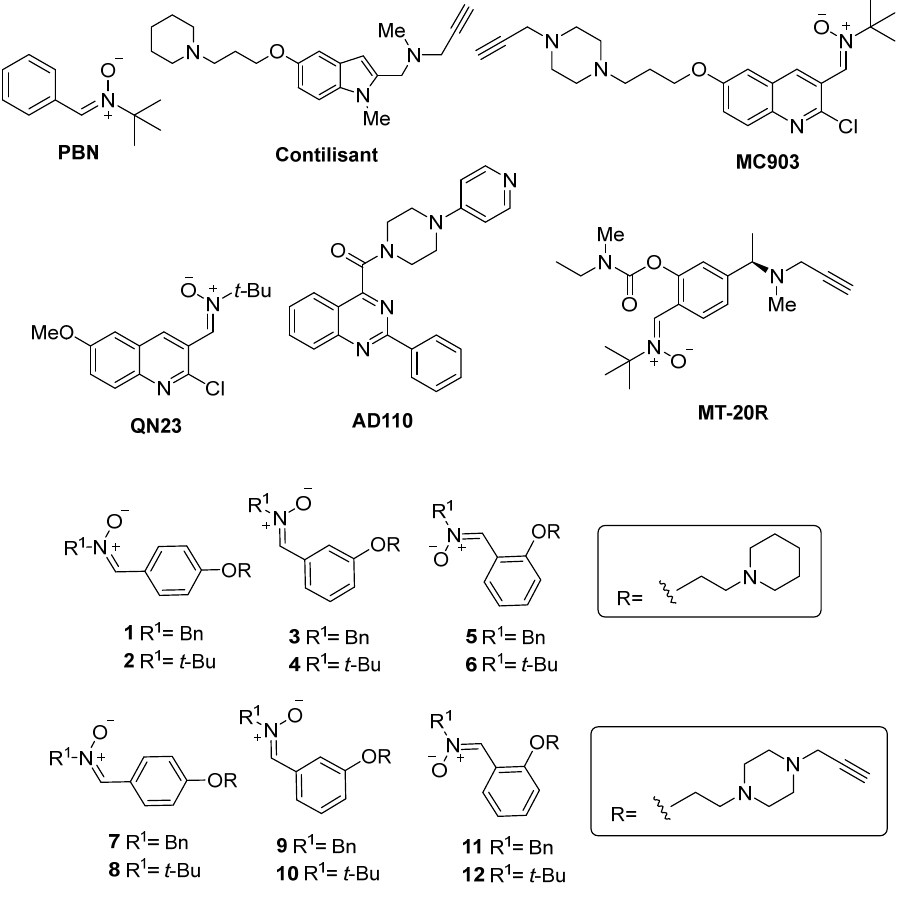
Figure 1. Structures of PBN , Contilisant , QN23 , MC903 , and the PBN -based nitrones 1 – 12 .